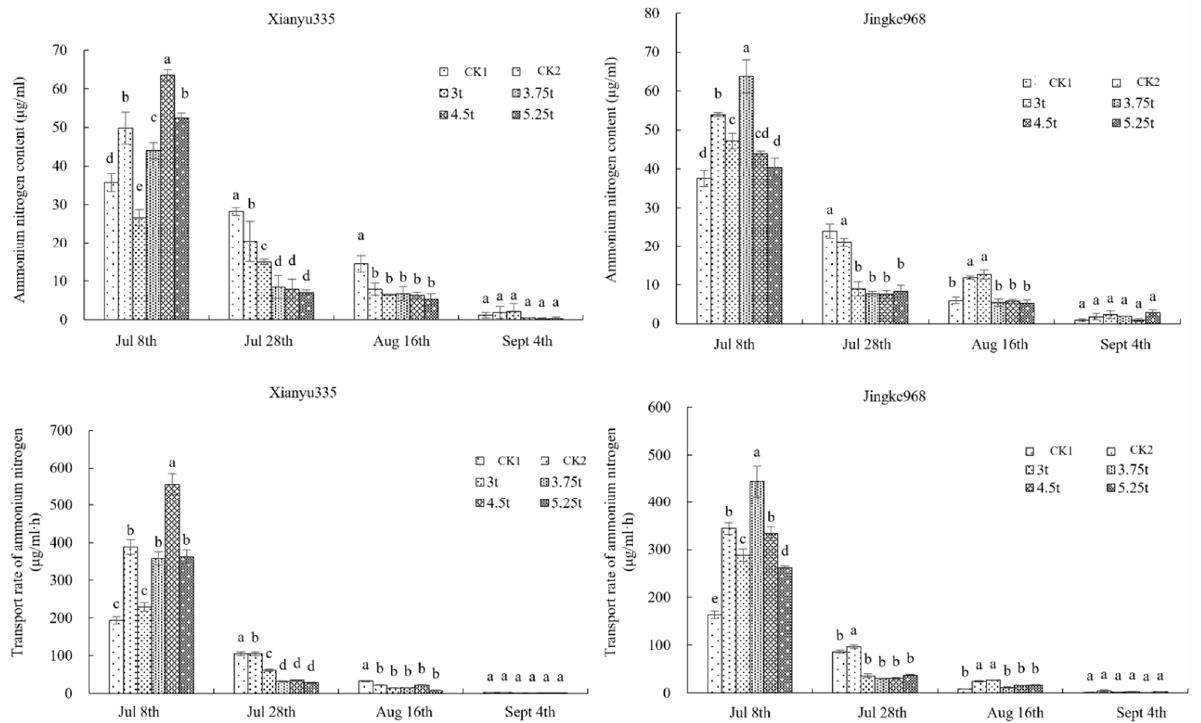
Figure 7. Effects of the carbon-based fertilizer on the ammonium nitrogen content and the transport rate in the maize root bleeding. Notes: data are expressed as mean ± standard deviation. Different letters within the same column indicate a significant difference at the 5% level.